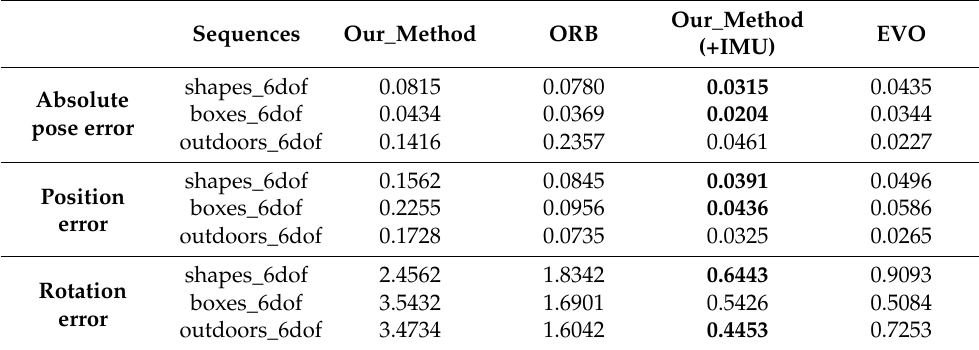
Figure 7. VO Experiment 3 (outdoors_6dof): ( a ) 3D event camera trajectories estimated by different algorithms; ( b ) Comparison of absolute pose errors between different algorithms; ( c ) The translation position of the camera estimated by different algorithms; ( d ) The rotation position of the camera estimated by different algorithms. Table 1. Absolute pose error (m/s), position error (m/s), and rotation error (deg/s) test results in different scenarios with different methods